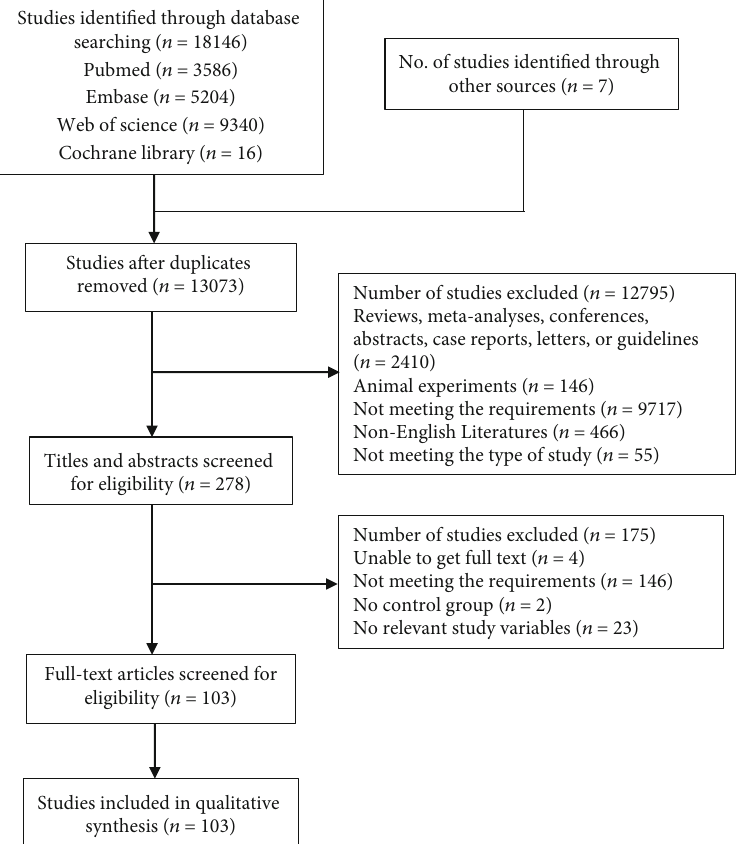
Figure 1: Flow diagram of search